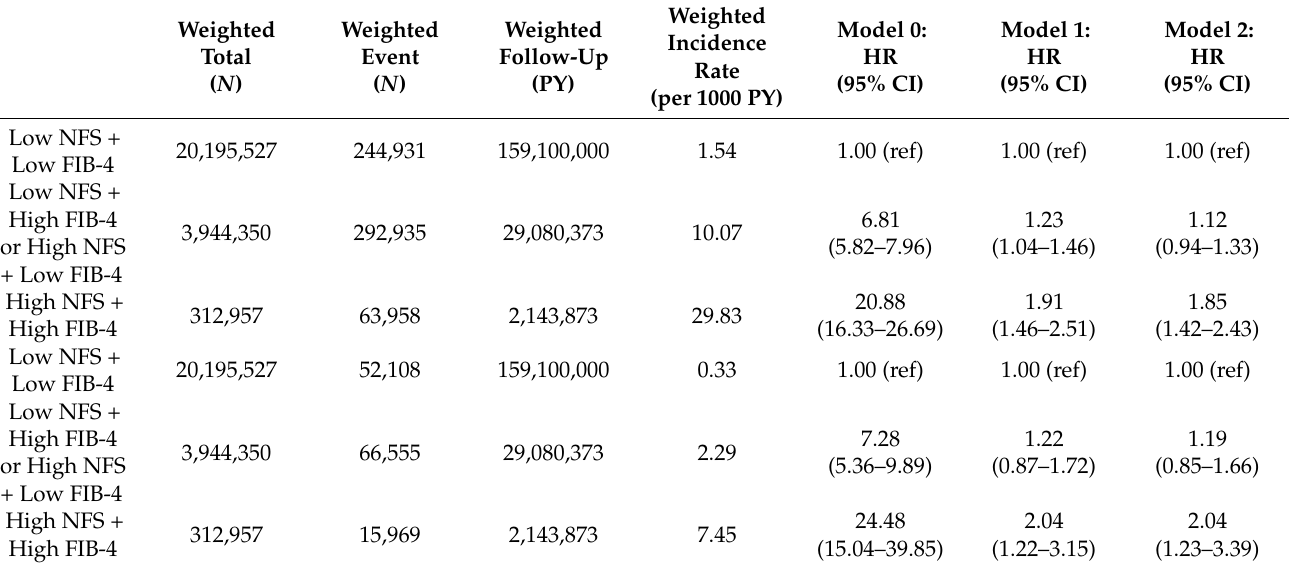
Table 3. Risk of all-cause and cardiovascular mortality according to the combination of NFS and